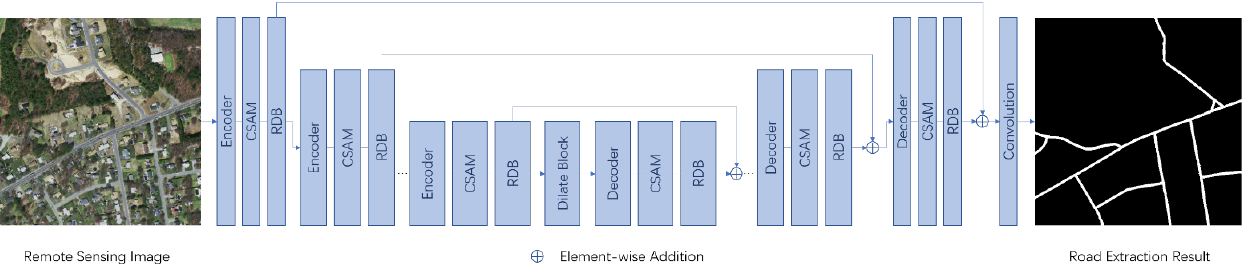
Figure 1. Schematic diagram of the proposed road extraction network.